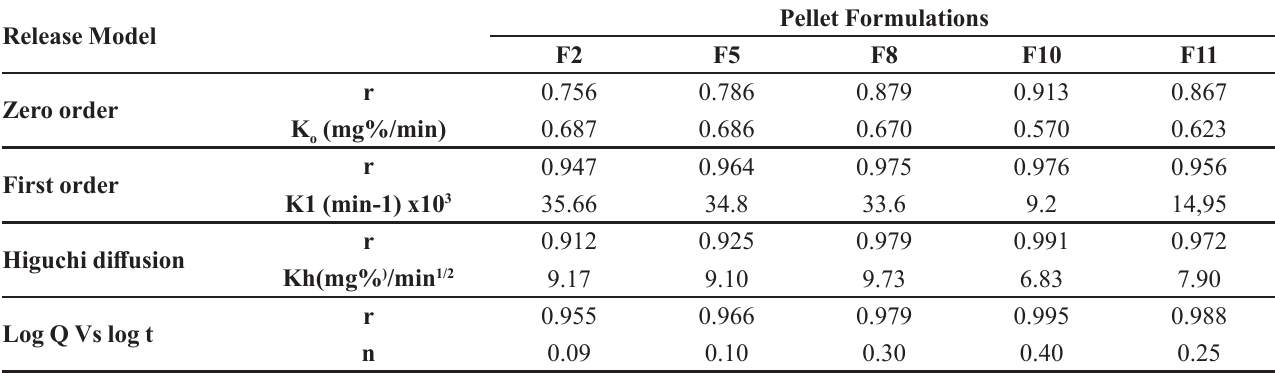
TABLE III - Kinetic modeling of drug release form pellets containing DM Release